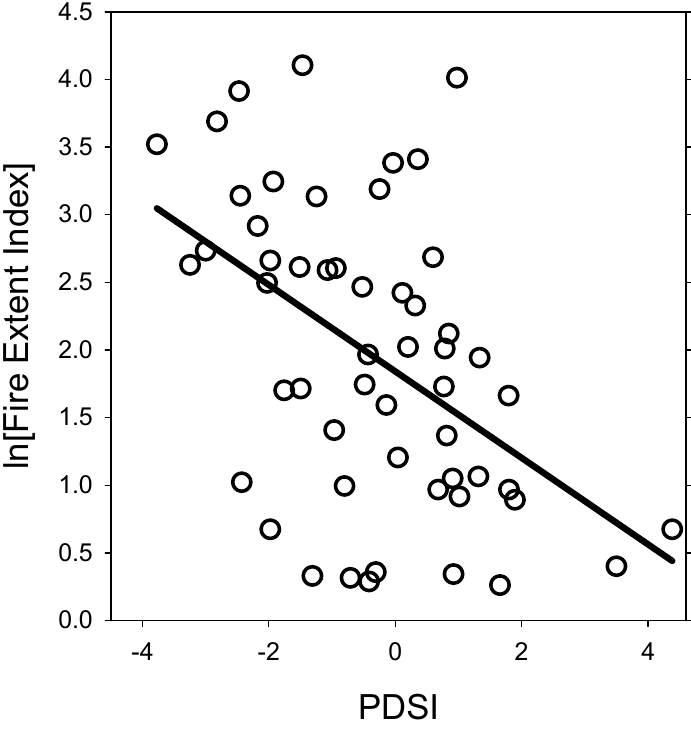
Figure 5. Scatterplot of the Fire Extent Index (FEI) and reconstructed Palmer Drought Severity Index (PDSI) for 54 historical fire years in the Northwest and Northeast Sands Ecological Landscapes of northern Wisconsin (Figure 1). Data are from the period 1660–1864. The regression indicates prediction of FEI from reconstructed drought (ln(FEI) = 1.84 − (0.32 × PDSI), Equation (2), r 2 = 0.23). Decreasing values of PDSI relate to increasing dryness.